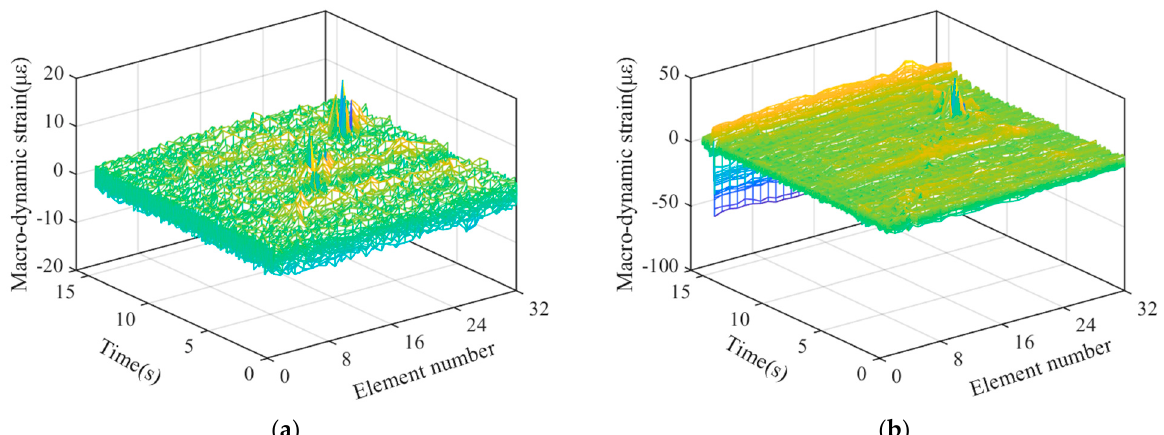
Figure 9. Macro-dynamic strain under damage condition for vehicle-to-bridge mass ratios; ( a ) 1.22; ( b )